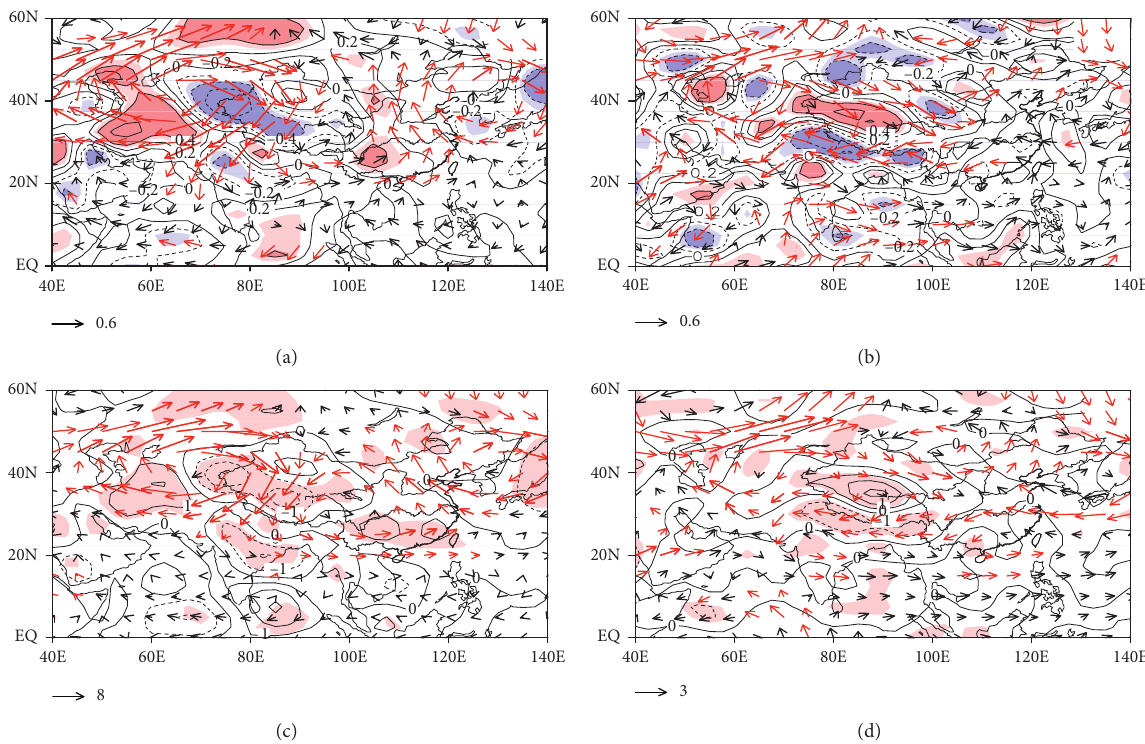
Figure 10: Correlation between the I W and the winds and divergence field (contours) at (a) 200hPa and (b) 600hPa. Composite anomalies of the winds and divergence field (contour) at (c) 200hPa and (d) 600hPa between the high- I W and low- I W conditions. The dark (light) shading in (a) and (b) indicates the correlation coefficients significant at the 99% (95%) confidence level. The shading in (c) and (d) indicates the divergence anomalies significant at the 95% confidence level. The red wind vectors indicate the zonal or meridional wind at the 95% confidence